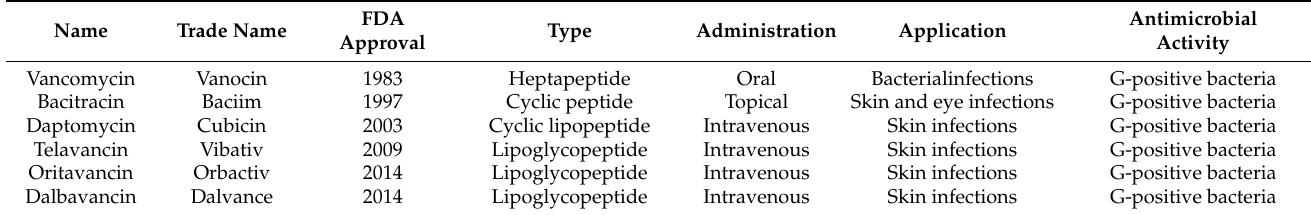
Table 1. Some antimicrobial peptide drugs approved by the